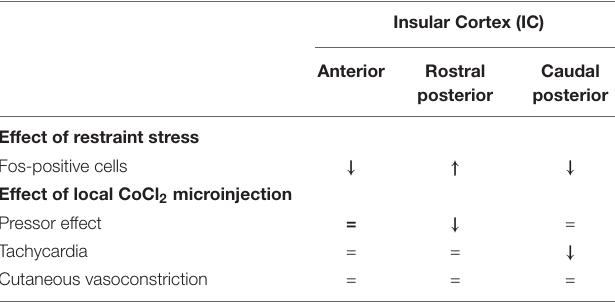
TABLE 2 | Summary of the main findings obtained in this